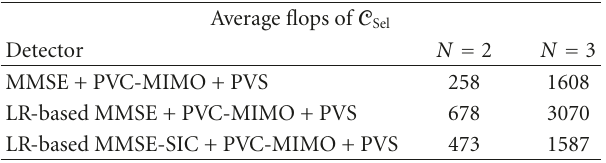
Table 1: Complexity comparison of C Sel for di ff erent detectors listed in Section